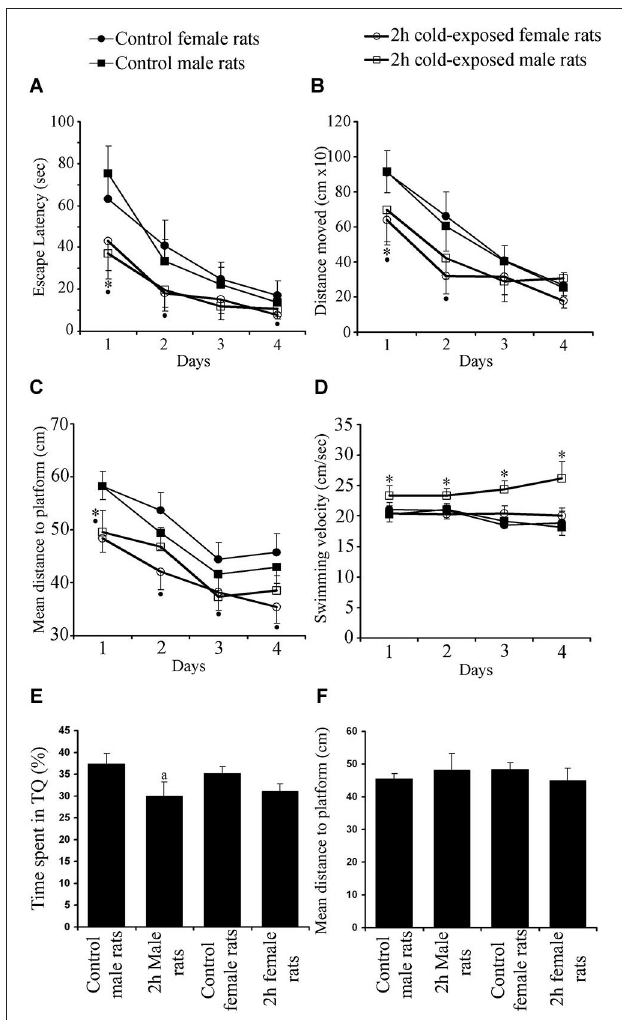
FIGURE 2 | Effects of cold exposure on acquisition performance in a task to find hidden platform in the water maze . All rats improved their ability as shown by decreasing escape latency (A) and distance moved ( B ) over training days. Control rats swam further away from the platform than experimental rats on the 1st and 2nd days as shown by mean distance to the platform ( C ). Swimming speed ( D ) did not change as a function of day. Measures per testing day represent the average of four trials of all animals in each group. Each symbol represents the mean ± SE of 10–12 rats. ∗ represents significant difference between cold exposed and control male rats; • represents significant difference between exposed and control female rats. Cold-exposed male rats spent less time in seconds in the target quadrant than the control male rats. Similar retrieval performance was observed between cold-exposed and control female rats ( E ). Mean distance to platform in the probe trial was not affected by Treatment or Gender ( F ).